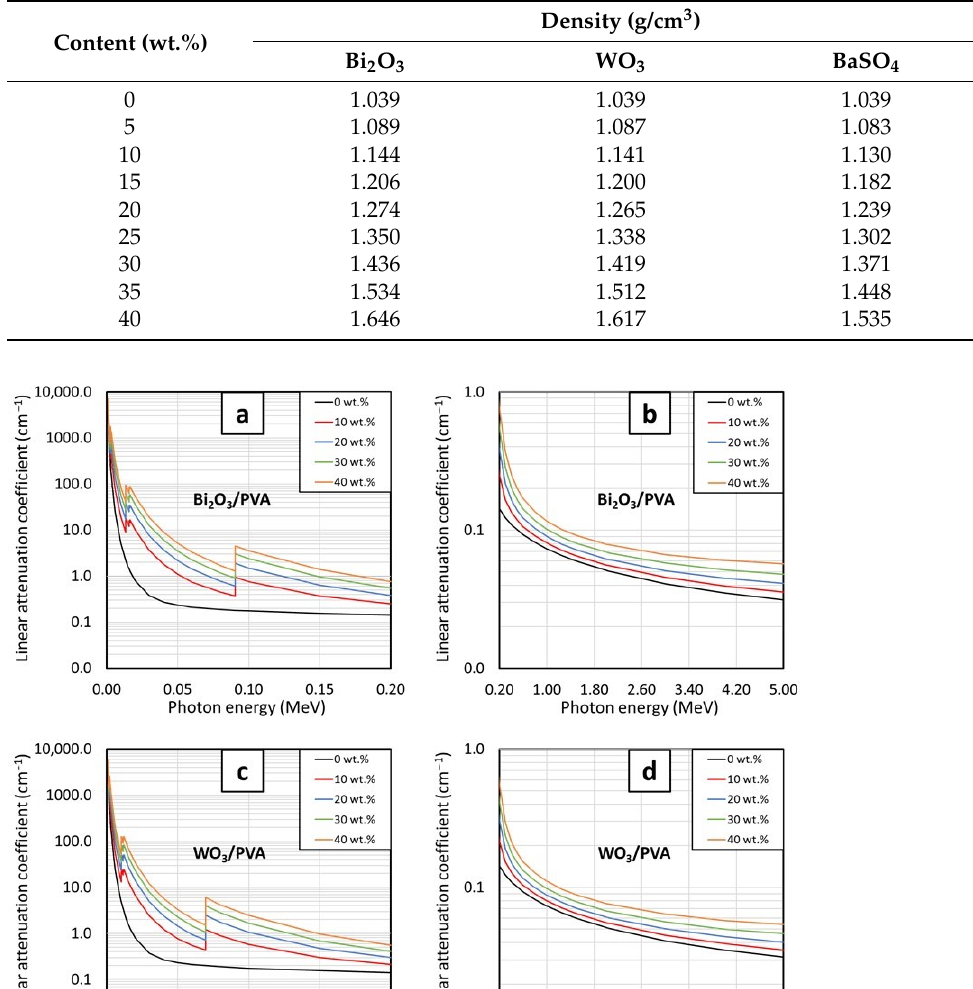
Table 4. Densities of PVA hydrogels containing Bi 2 O 3 , WO 3 , and BaSO 4 with varying contents of